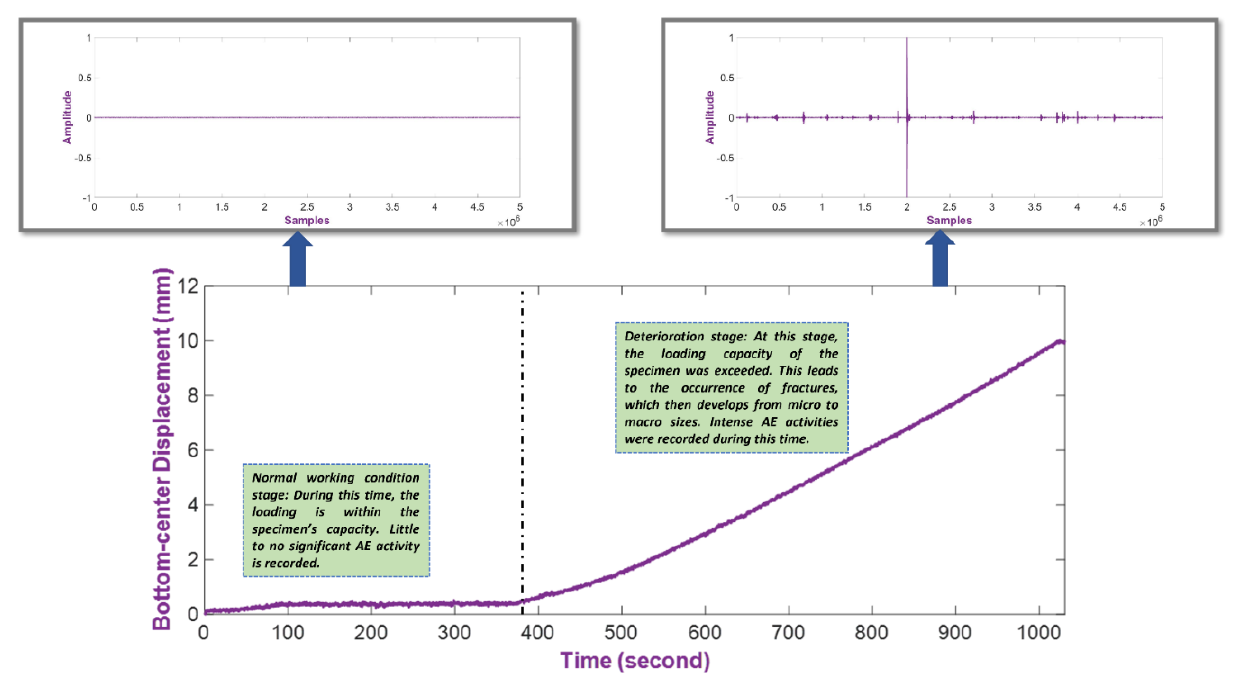
Figure 2. Vertical displacement of the specimen and signal difference in two loading stages.